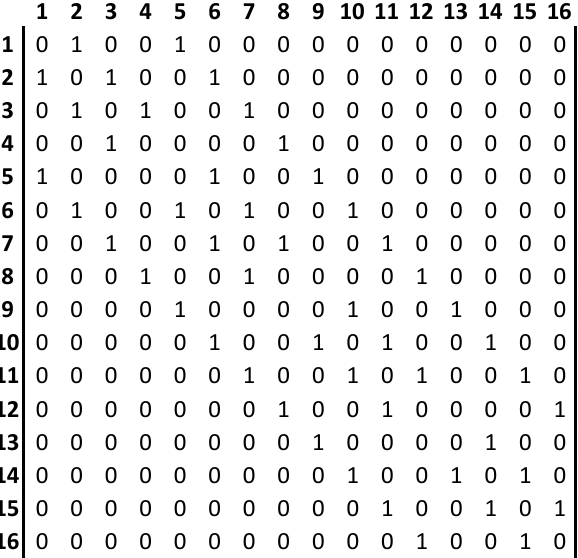
Table 5. Area of each region. Region ID